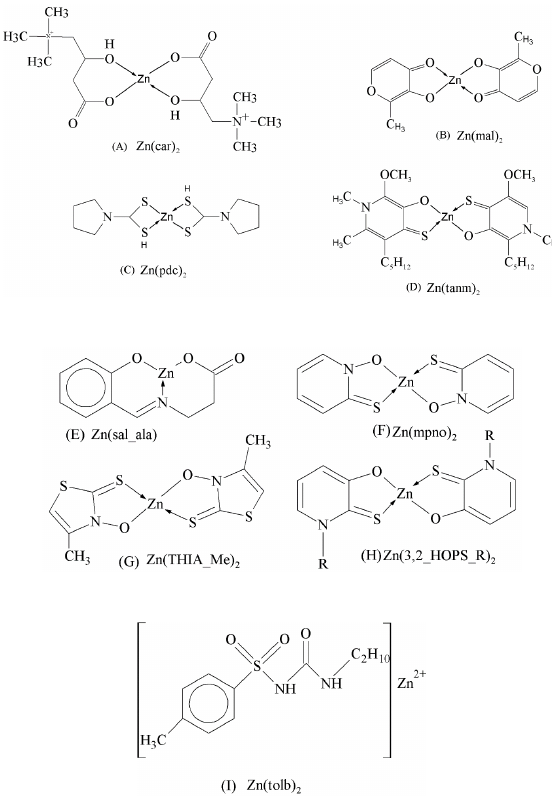
Scheme 11: Glipizidemetal